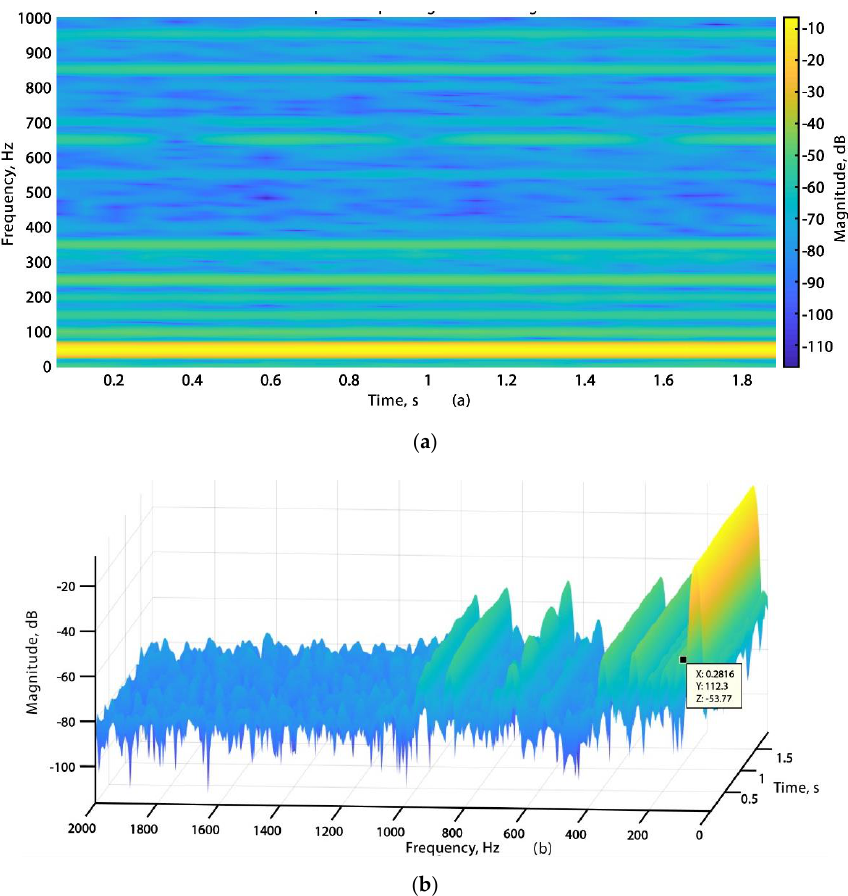
Figure 5. Amplitude spectrogram of the SCIG. ( a ) 2 dimensional STFT, ( b ) 3 dimensional STFT.